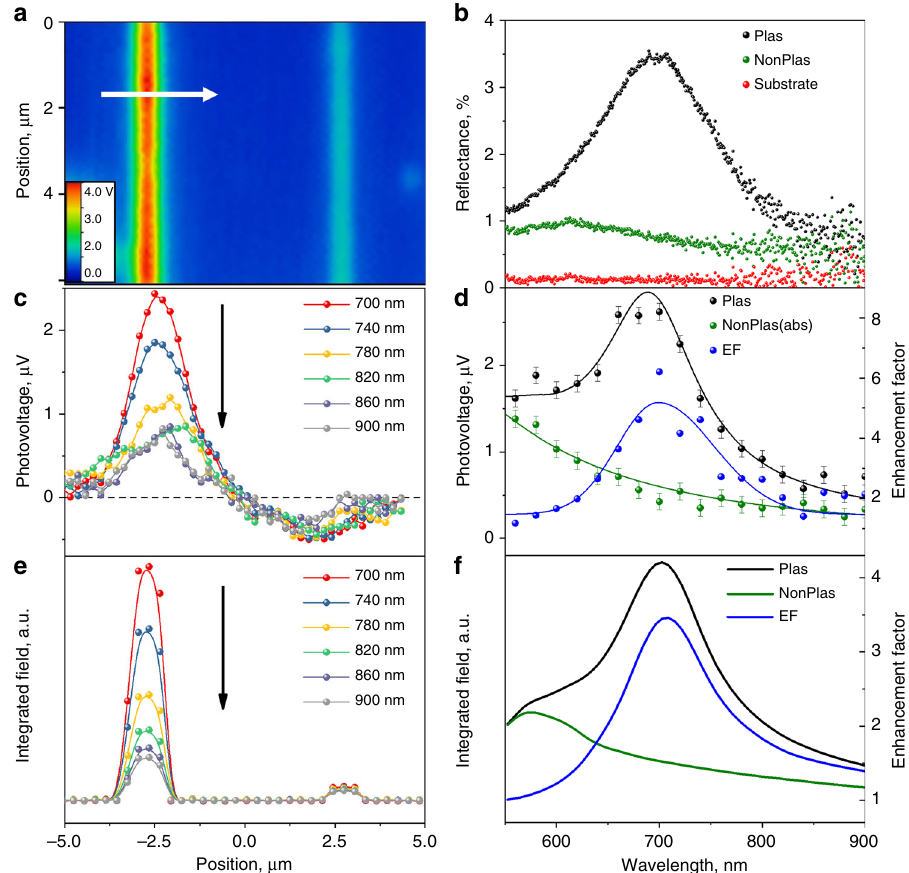
Fig. 3 Plasmon-enhanced graphene photoresponse. a Dark fi eld microscopic image of the graphene device with plasmonic (left) and nonplasmonic contacts (right). b Corresponding dark fi eld re fl ection spectra. c Photovoltage line scans across the device in the direction indicated by the arrow in a taken at different excitation wavelengths. d Wavelength dependence of the photovoltage (absolute value) from the plasmonic and nonplasmonic contacts. Enhancement factor is determined as following V Plas / V NonPlas . The photovoltage measurements are performed with an elliptical laser spot with 40 µ W power. e Calculated line scan of the integrated electromagnetic fi eld. f Calculated wavelength dependence of the integrated electromagnetic fi eld and enhancement factor (Plas/NonPlas). The error bars are the standard deviation in the